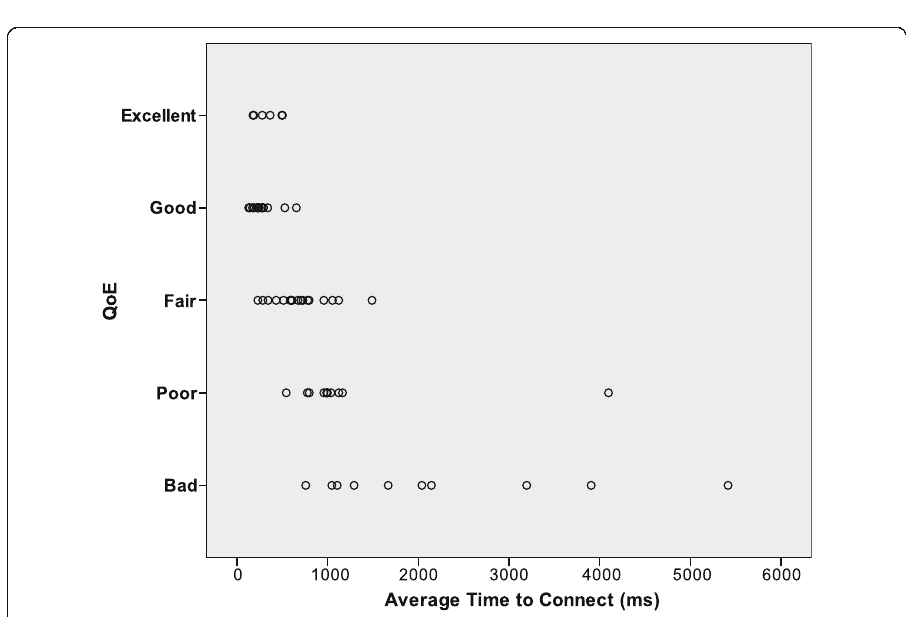
Fig. 3 Scatter plot of QoE vs. Average-Time-to-Connect-TCP [15]